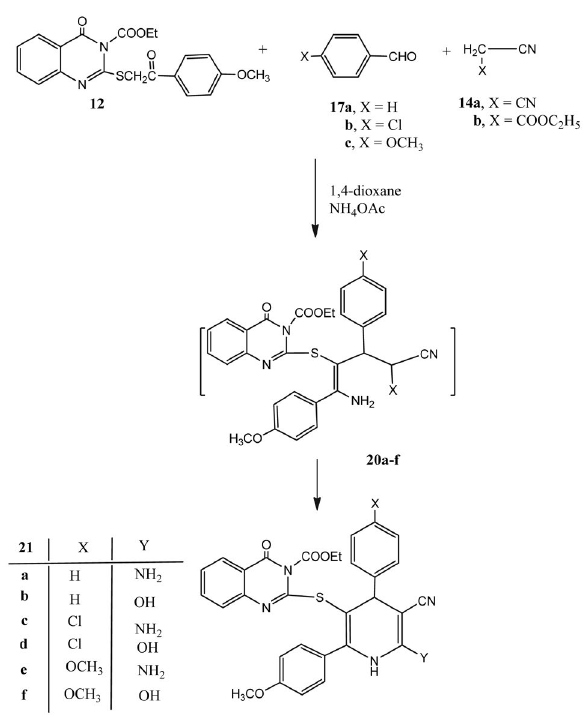
Scheme 4: Synthesis of compounds 21a-f